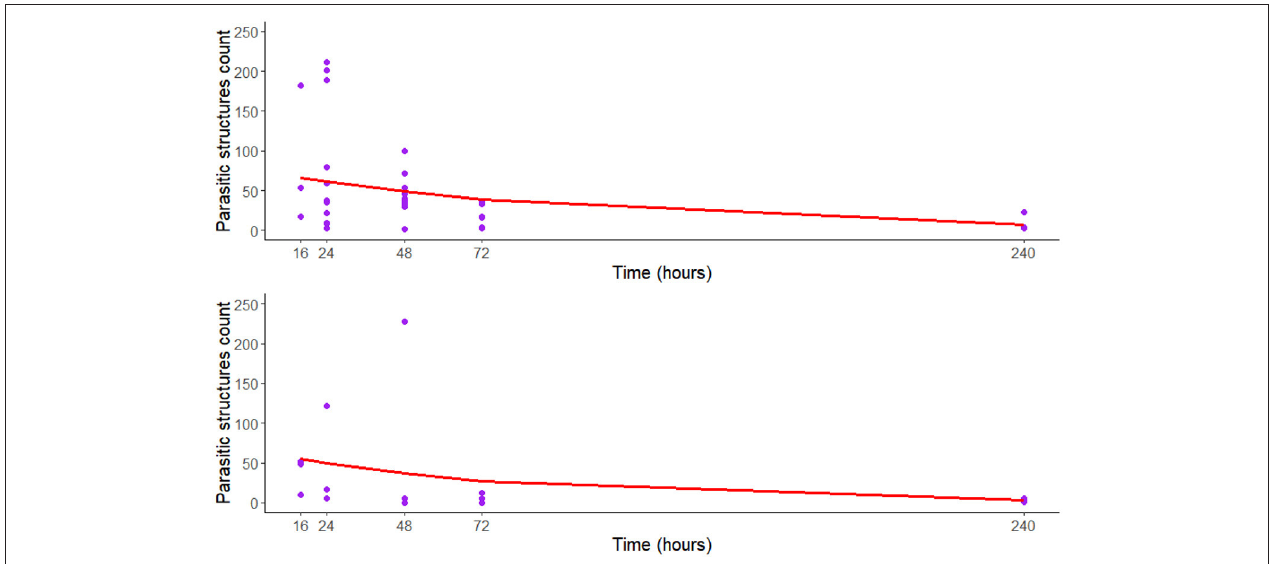
FIGURE 1 | Regression curve of the negative binomial model to assessment T. canis eggs and larvae recovered of aquatic environment (upper) and in the gastrointestinal tracts (GIT) of Nile tilapia (lower) experimentally inoculated with T. canis embryonated eggs, overtime ( n =